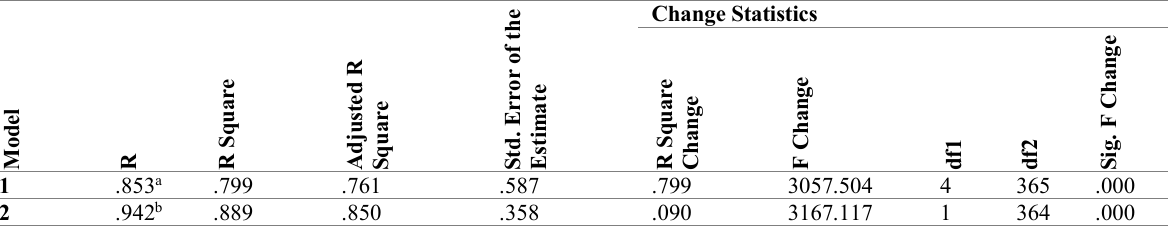
Table 13: Regression model after